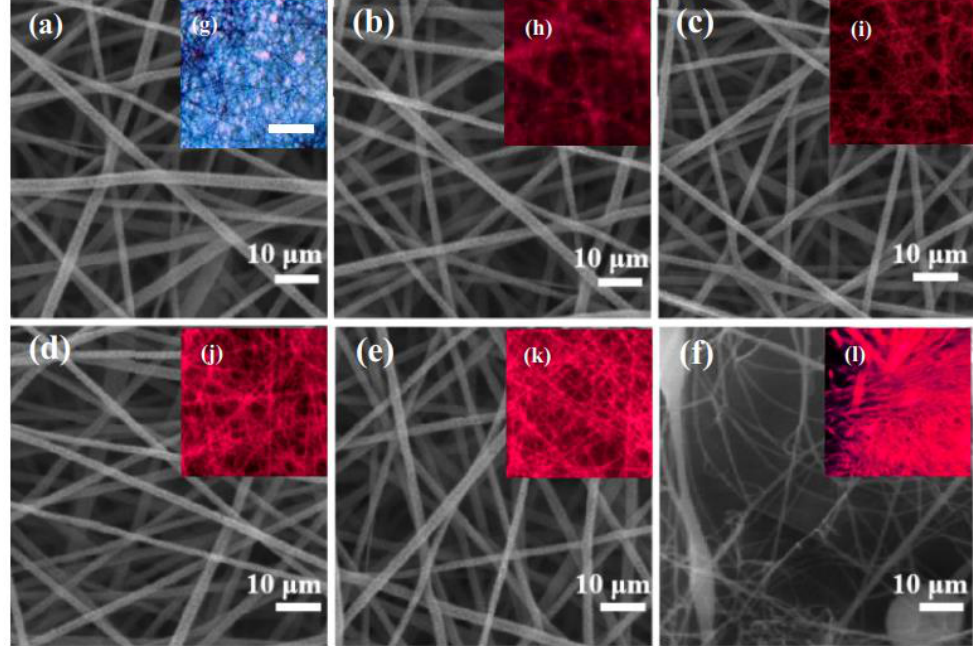
Figure 3. SEM ( a – f ) and the microfluorescence images ( g – l ) (under UV excitation); CdSe QD content of 0% wt ( a , g ), 1% wt ( b , h ), 2% wt ( c , i ), 3% wt ( d , j ), 4% wt ( e , k ) and 5% wt ( f , l ). The scale bar for ( g – l ) is 100 μ m.